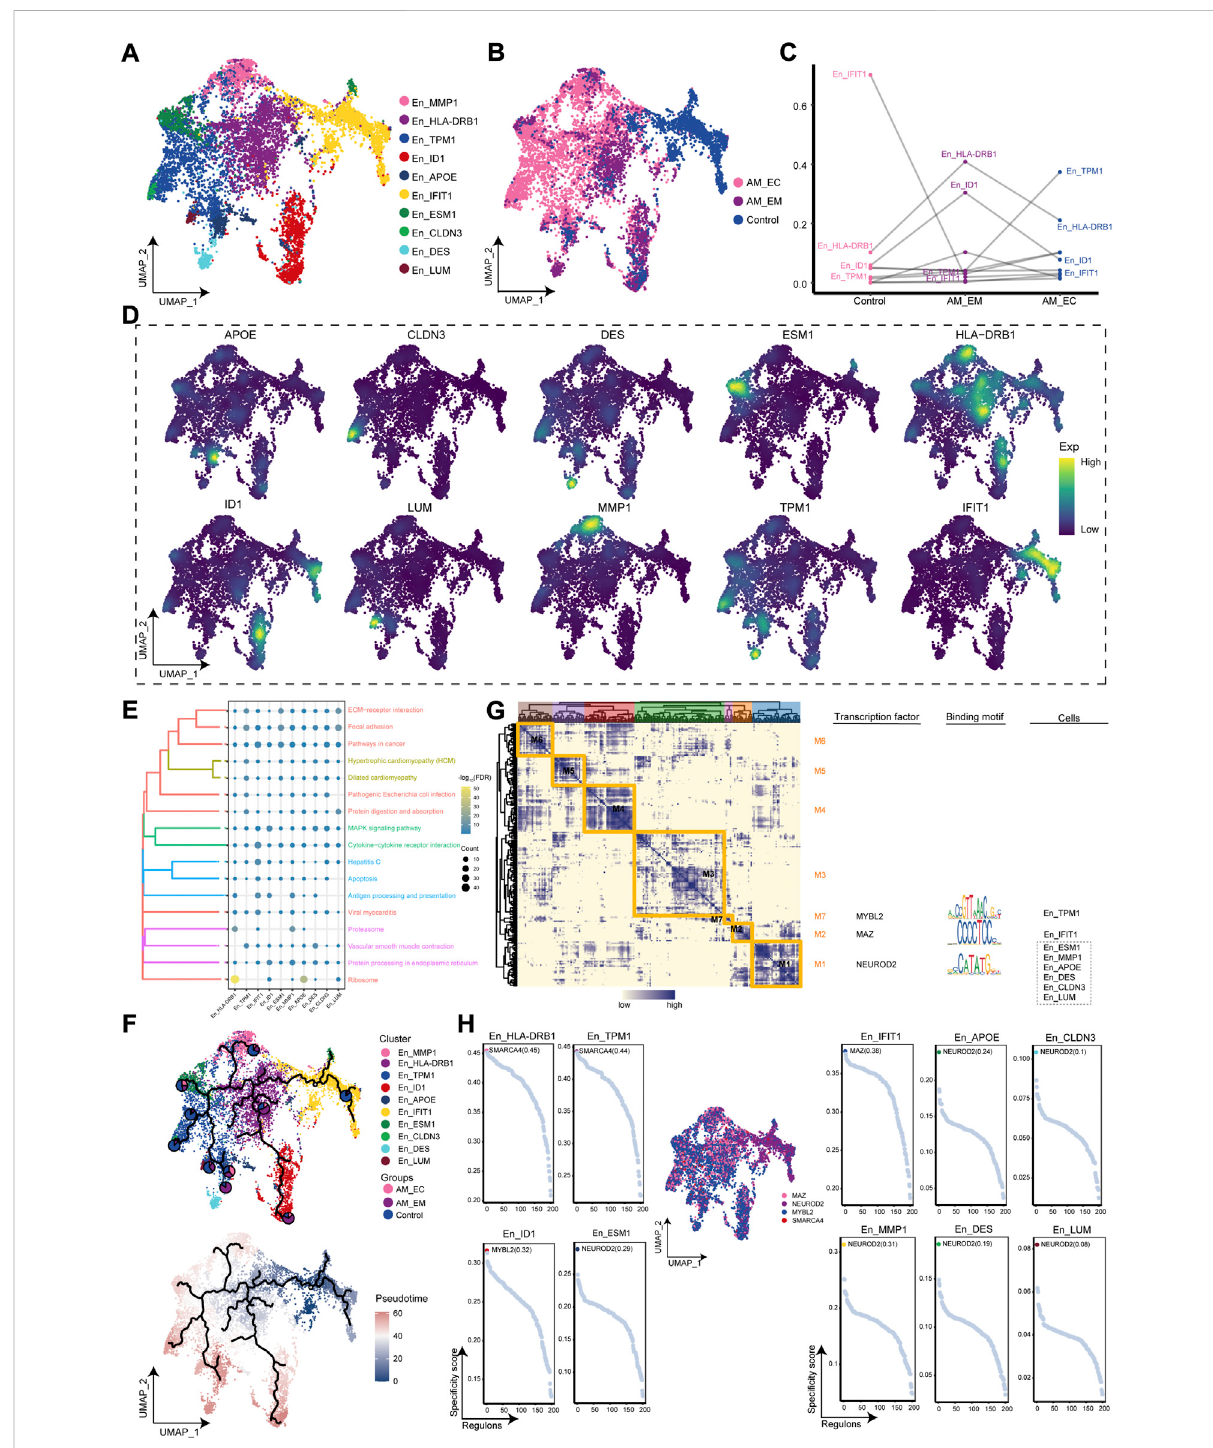
FIGURE 3 The adenomyosis(AM)-associated endothelialcell (En) clusters. (A) .Single-cell atlasshows thecell clusters of endothelial cells (En). (B). Single- cellmappedtheEnclustersintheeutopicendometrium(AM_EM),ectopicendometrial(AM_EC),andcontrolgroupsofAMpatients. (C). Differences intheabundanceofEnclustersamongtheAM_EM,AM_EC,andcontrolgroups. (D). Markergenesforspeci fi cEnclusters. (E). Biologicalpathwaysin speci fi c En clusters. (F). Single-cell atlas map the trajectory and pseudotime values of development in En from AM. Pie charts show the proportion of the different groups in the clusters. (G). Transcription factors of En clusters in a co-expression pattern. Left: Heat map identi fi es co- expression modules;middle: major transcriptionfactorsandbindingsequences;right:cell clustersoftranscriptionfactors. (H). Transcription factors regulated makers of EC clusters. AM_EM, eutopic endometrium; AM_EC, ectopic endometrium; UMAP, Uniform Manifold Approximation and